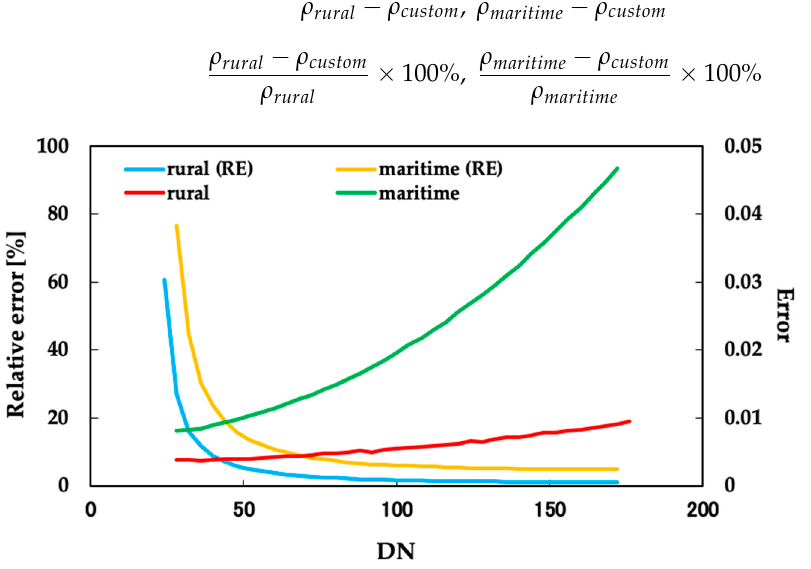
Figure 10. Error estimation of the custom aerosol model, comparing with maritime and rural aerosol models. The absolute values and the relative values for error created from conventionally ‐ used typical aerosol models as illustrated on right axis and left axis, respectively.